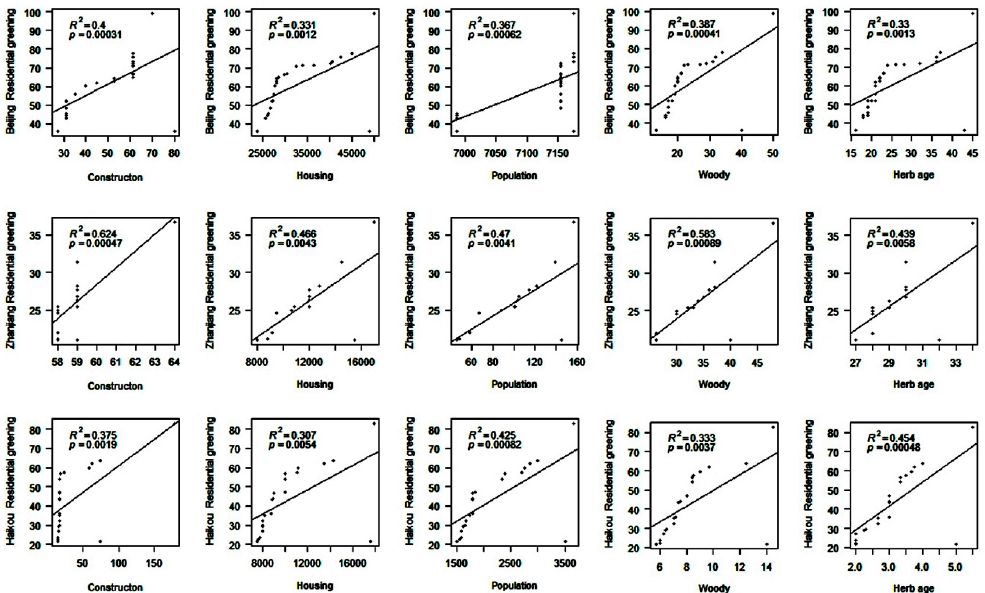
Figure 8. Scatterplots depicting the relationships between the greening percentages of Residential areas and both socioeconomic variables (construction age, housing price, and population density) and species richness (woody and herbaceous) within Beijing, Zhanjiang, and Haikou.